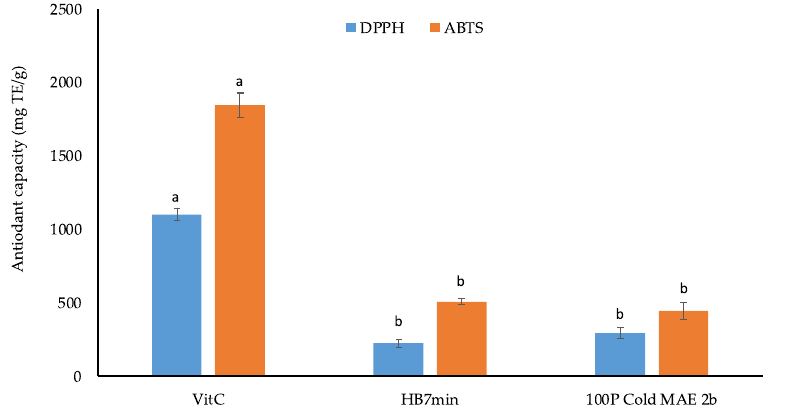
Figure 10. Antioxidant activity of vitamin C in comparison with herbal tea extracts prepared from hot brewing for 7 min, microwave assisted extraction with cold water at full power. Data for each